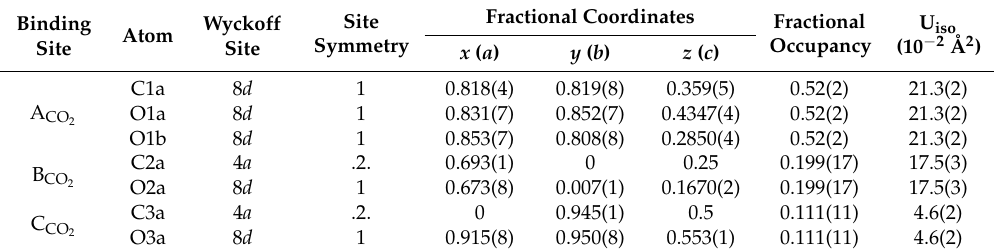
Table 1. Crystallographic details for CO 2 sites within Y(btc) at a dose of 1 CO 2 :Y.